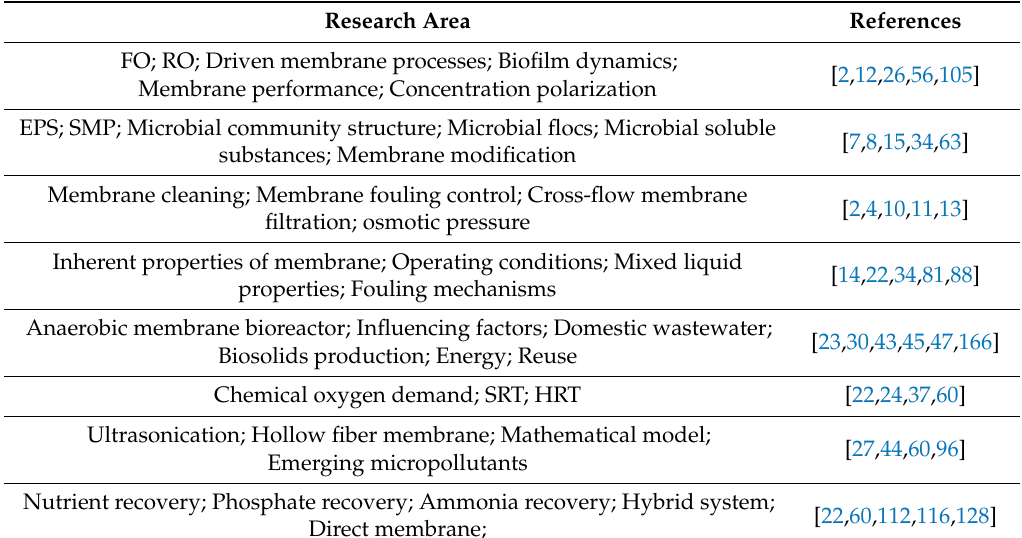
Table A1. Review papers on membrane fouling in specific areas in recent